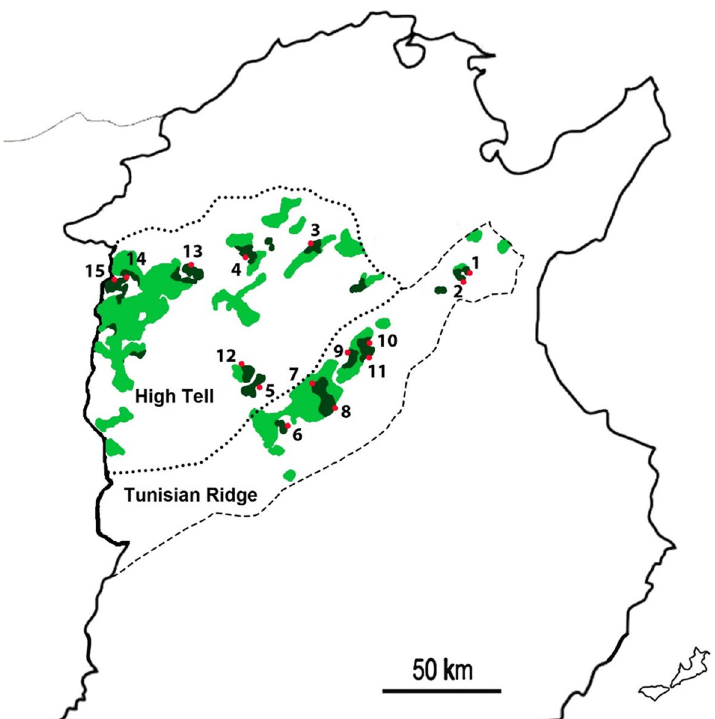
Fig. 1 Distribution map of Quercus ilex populations in Tunisia. The current Q. ilex distribution (dark green areas) was estimated in this study, while the past distribution area (light green surfaces) is based on the last national forest inventory of 1990 (Nabli 1989). All populations of Q. ilex are distributed in the two mountainous regions of the High Tell and the Tunisian Ridge. Locations of the 15 woodlands sampled are indicated by